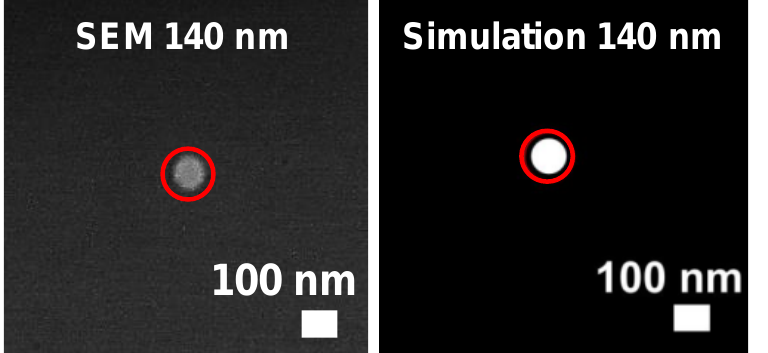
Figure 6. SEM image ( left ) of a single site-controlled Ga droplet for d = 140 nm together with a corresponding simulated surface morphology ( right ). The red circles indicate the size of the aperture. The experimental and simulation parameters are as in Figure 5. In the simulations, during deposition T = 50 °C is assumed (see Section